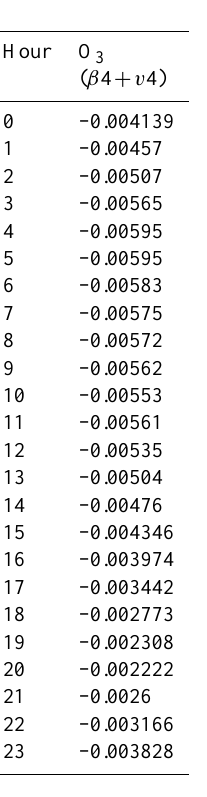
Table A2. Coefficients for the function (1).